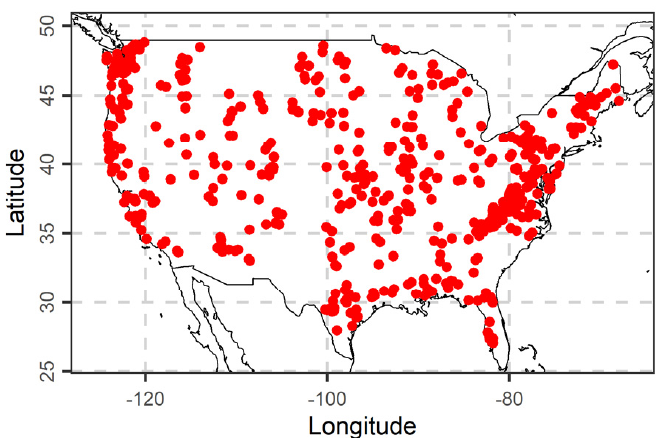
Figure 2. The 511 river basin stations over CONUS examined in the study.